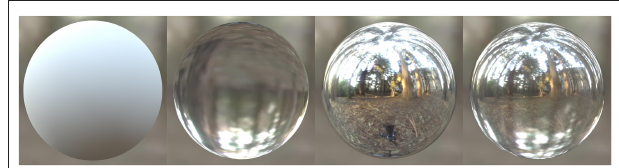
FIGURE 1 | Object surface property affects perceptual thickness. Smooth spheres with different material properties are shown: diffuse, transparent, specular, and transparent + specular (1:1) from left to right. The transparent object appears flatter than the other objects, while the specular object and transparent + specular (1:1) object look thicker than the other